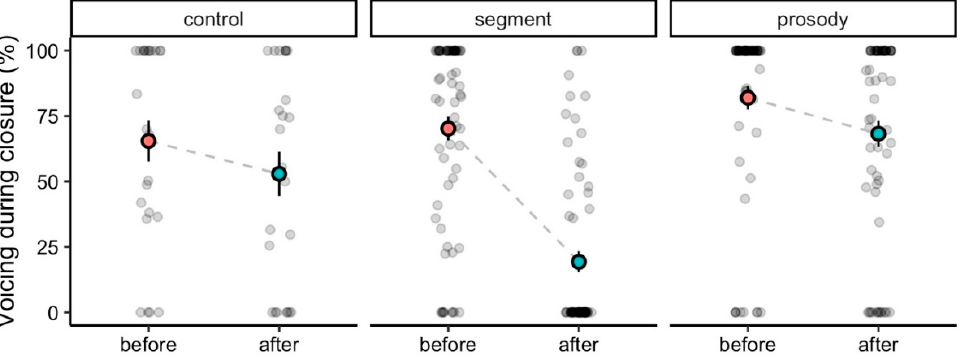
Figure 3. Voicing during closure (in %) for training groups before and after training (coloured thick points with bars: means and standard errors; grey points: raw measures).